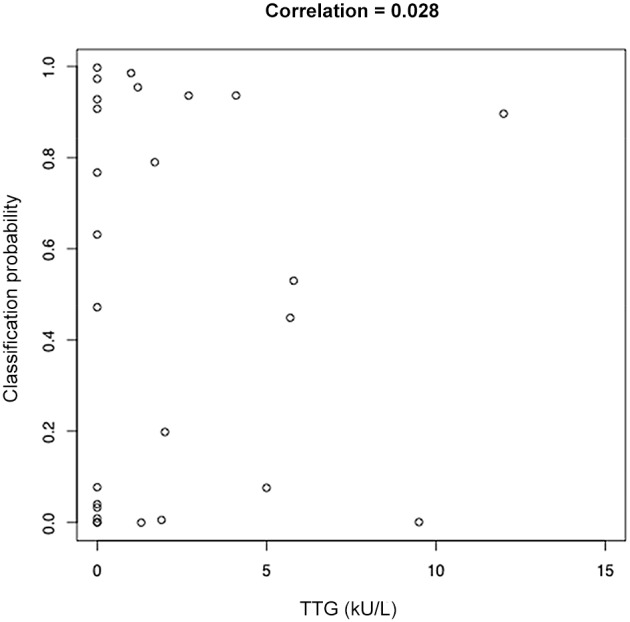
Scatter plot of TTG serology vs classification probability for Coeliac cases.The classification probabilities are the probability of a given patient having Coeliac disease, as determined by the sparse logistic regression algorithm. The overall correlation of these points is 0.28. One outlying point with TTG>60 kU/L has been removed.